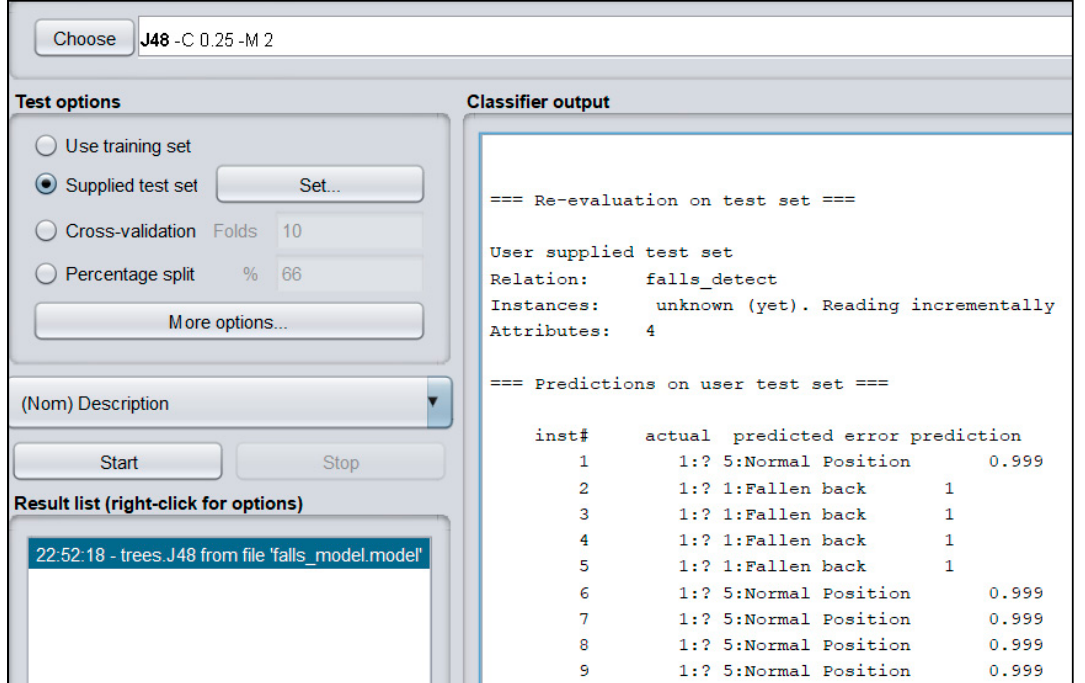
Figure 13. Results were obtained by applying the model to the test group.